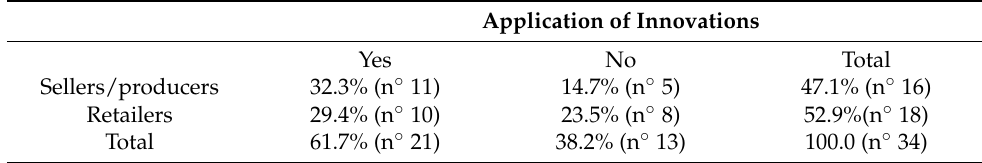
Table 6. Seller/producer and retailer